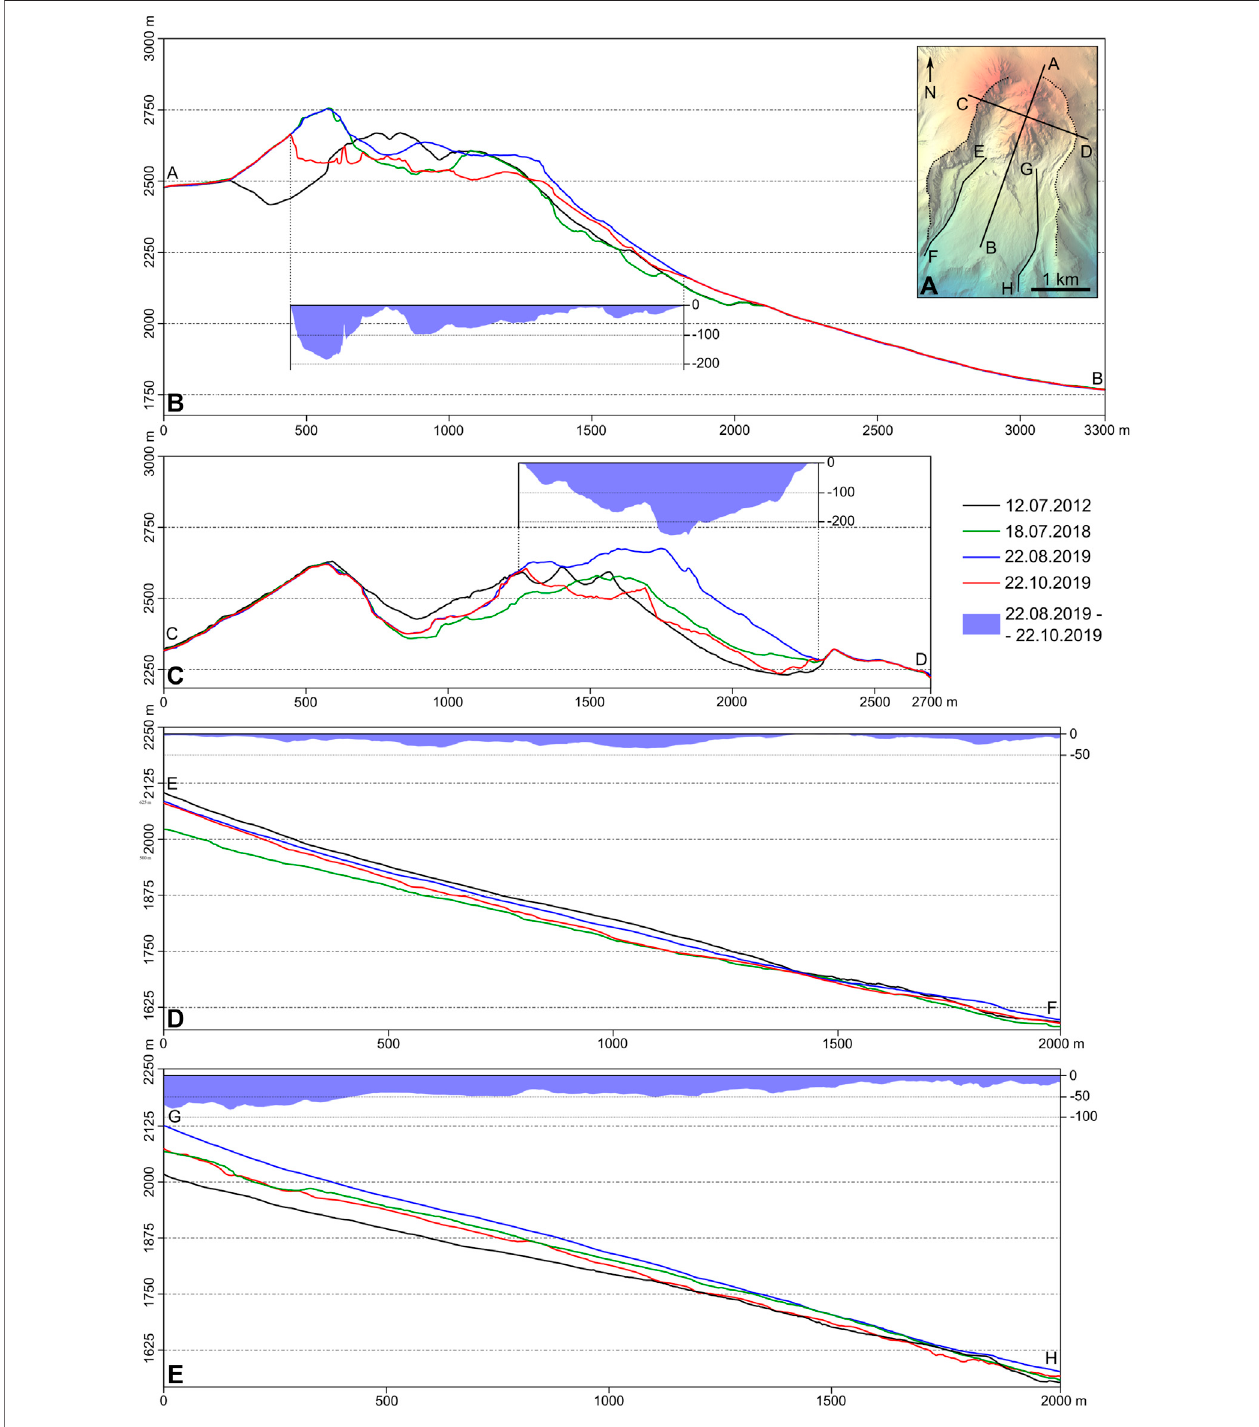
FIGURE 6 | Topographic pro fi les of the Shiveluch lava dome (B,C) and collapse scars (D,E) . The pro fi le lines are shown in the insert map (A) . The blue shading represents a negative difference between the pre- and post-2019 destructive events.